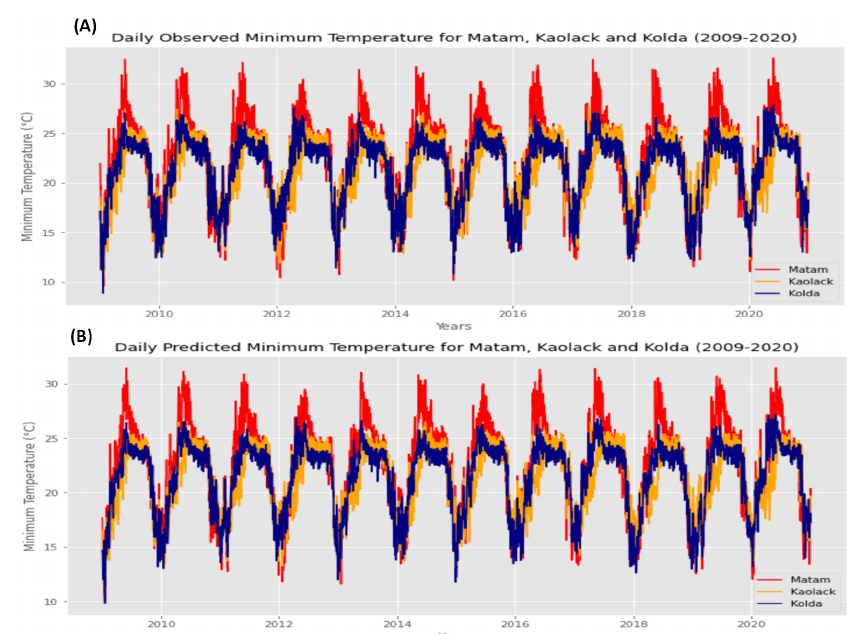
Figure 22. Observed and Forecasted Minimum Temperature for Matam, Kaolack and Kolda (2009–2020).